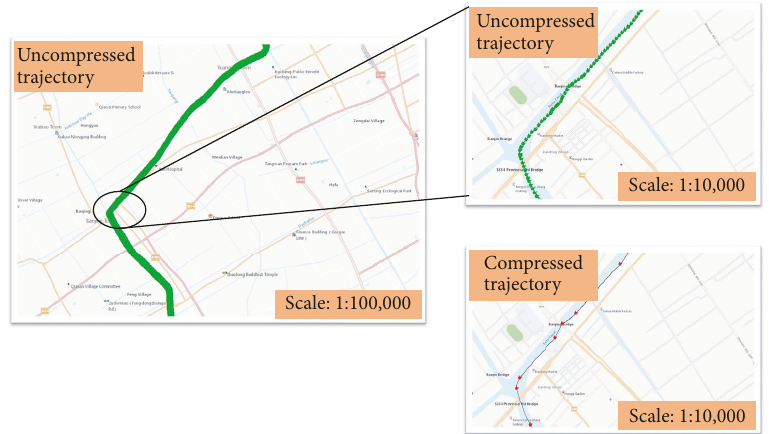
Figure 14: Trajectory presentation of uncompressed data and compressed data of SW.